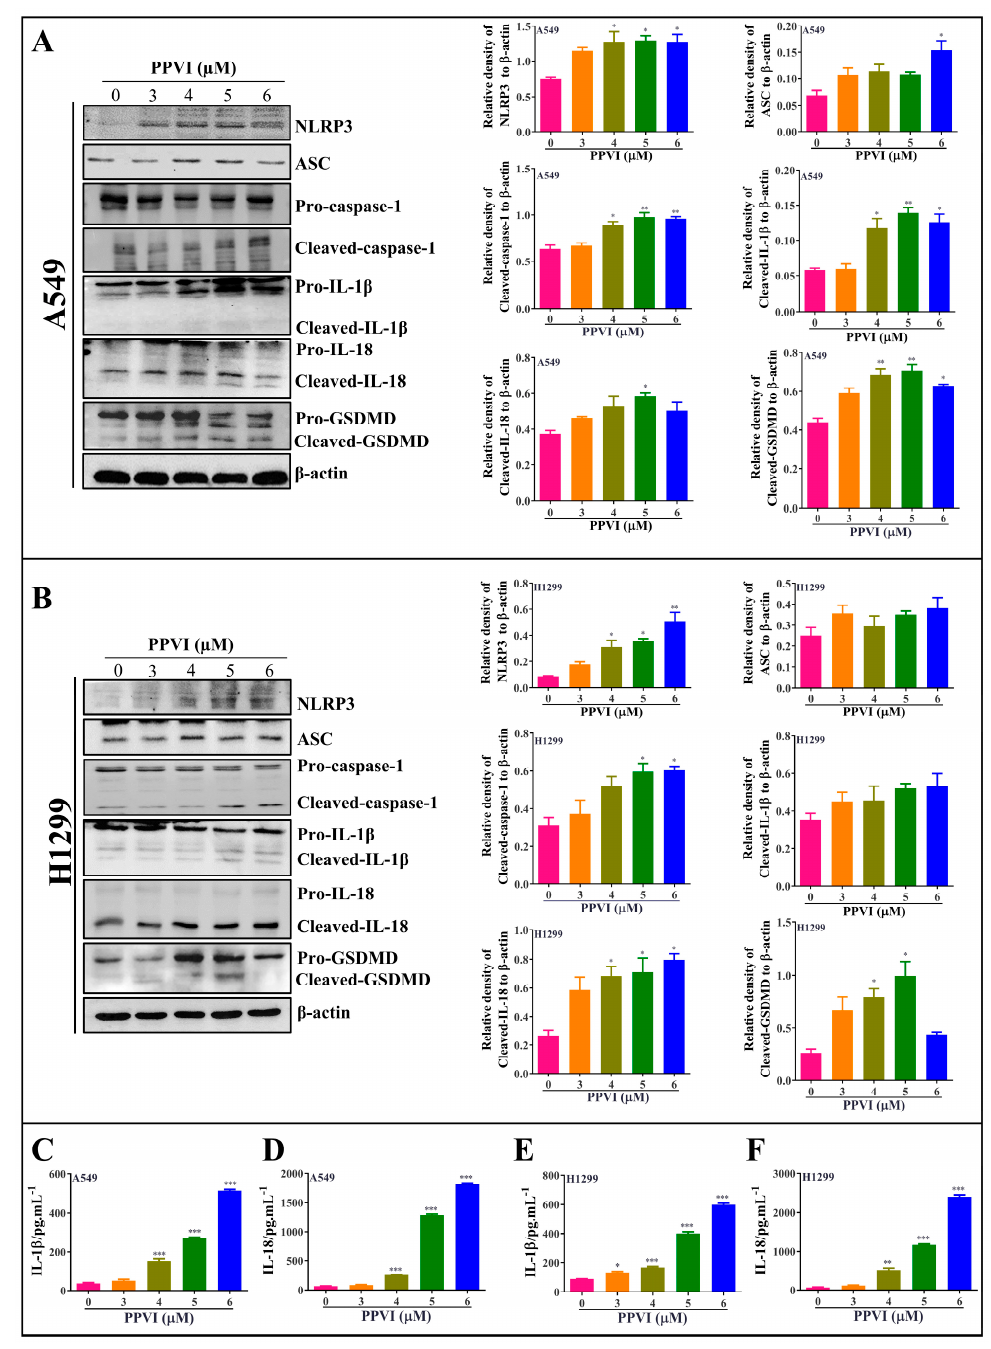
Figure 5. PPVI activated the NLRP3 inflammasome and promoted the release of IL-1 β and IL-18. A549 cells ( A ) and H1299 cells ( B ) were treated with PPVI as indicated by the graded concentrations for 24 h. Cell protein was then harvested for detecting NLRP3, ASC, caspase-1, IL-1 β , IL-18, GSDMD and β -actin by Western blot. Bar chart indicates the relative density of protein to β -actin; bars, S.D. * p ≤ 0.05; ** p ≤ 0.01. The full-length Western blotting images are shown in Figure S5. A549 cells and H1299 cells were treated with PPVI as indicated by gradient concentrations for 24 h. Culture medium was collected for centrifugation and the supernatant was used for the detection of the level of IL-1 β and IL-18 by using a Human IL-1 β ELISA Kit (CHE0001) and a Human IL-18 ELISA Kit (CHE0007). Bar chart indicates the level of IL-1 β and IL-18 in the cell supernatant of A549 cells ( C , D ) and H1299 cells ( E , F ), respectively. bars, S.D. * p ≤ 0.05; ** p ≤ 0.01. *** p ≤